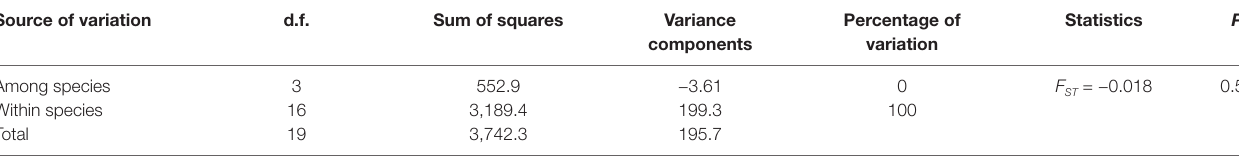
TaBle 3 | AMOVA testing genetic subdivision among mainland species. Source of variation